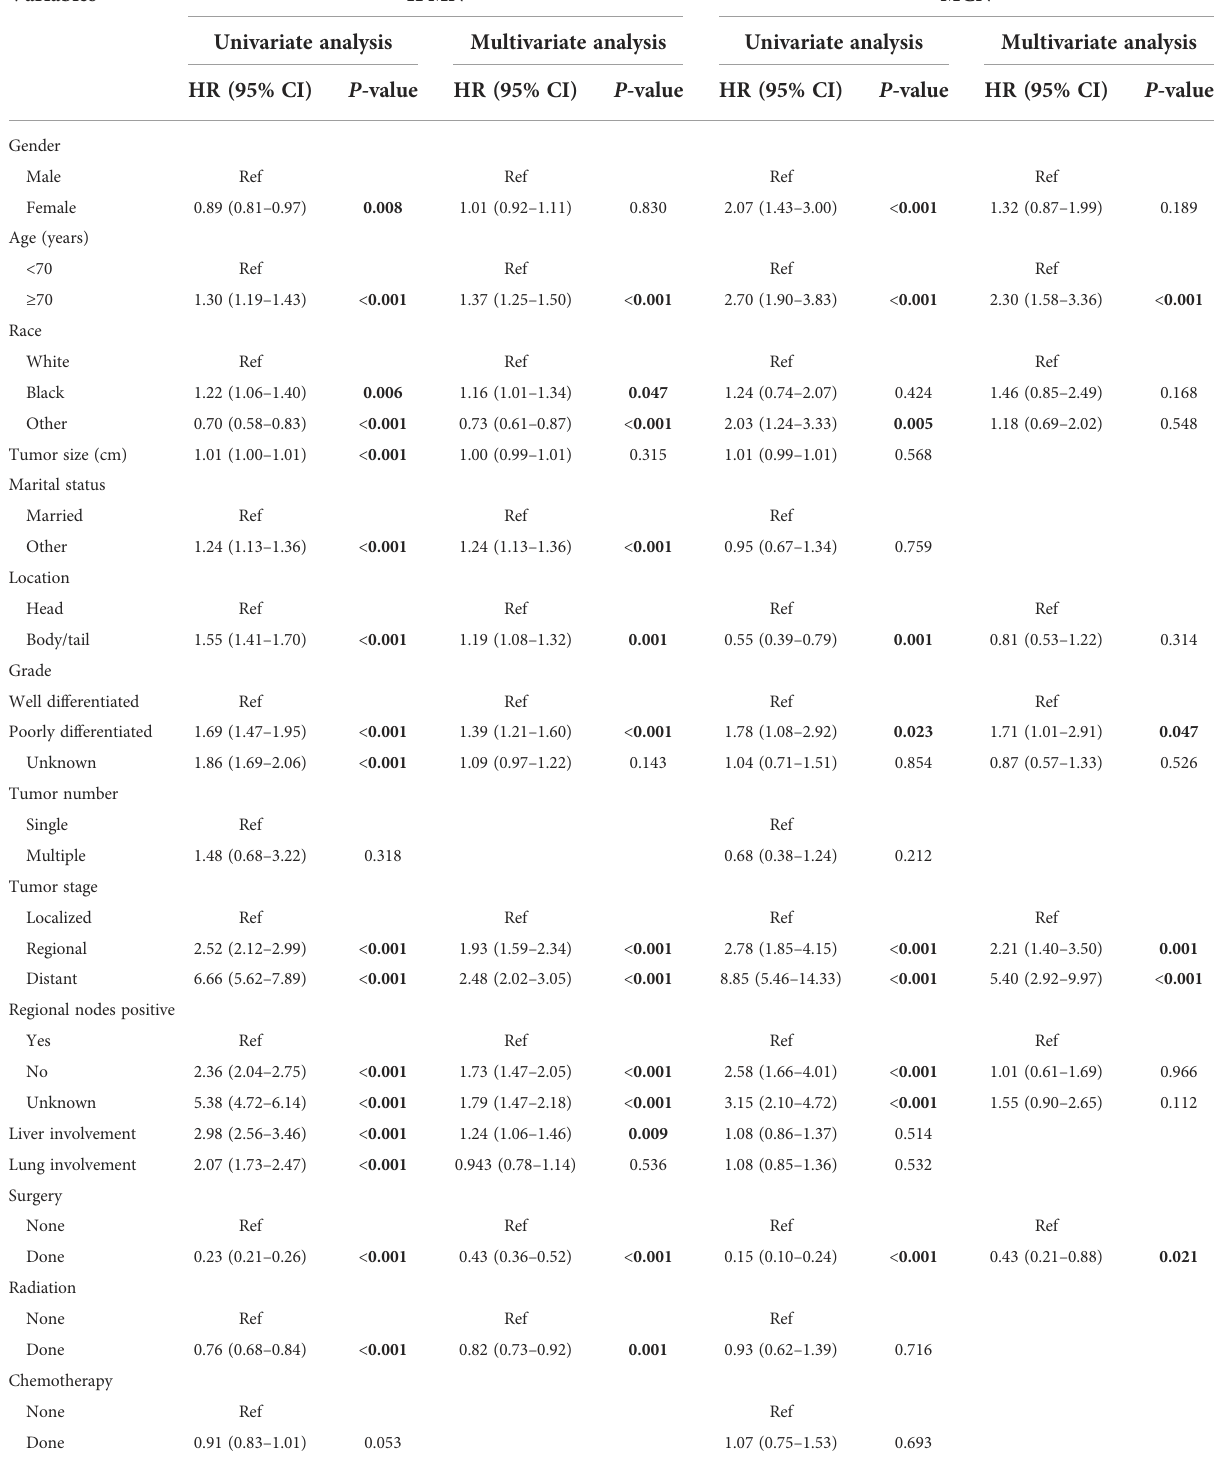
TABLE 5 Univariate and multivariate analysis for overall survival in IPMN and MCN patients.